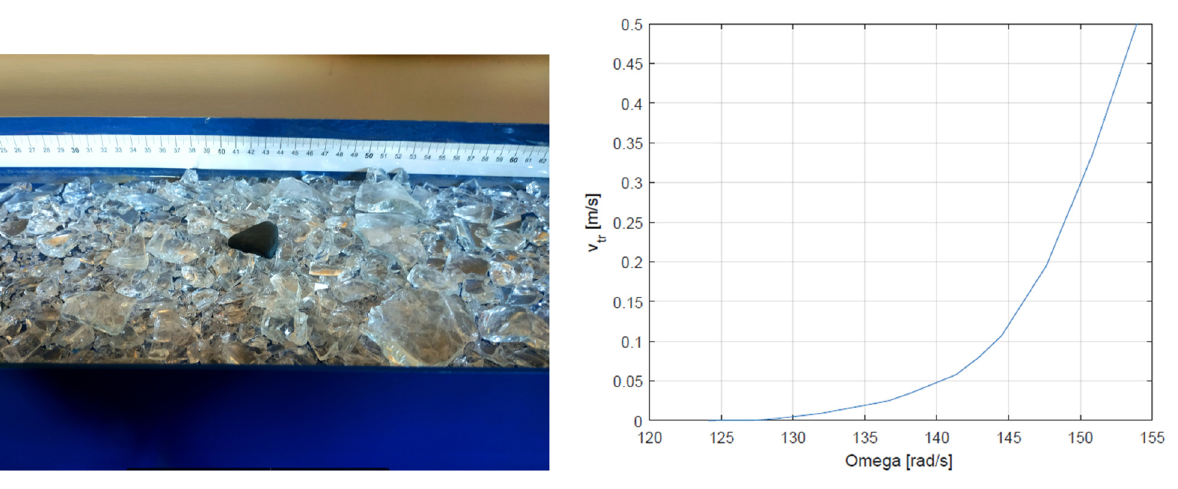
Figure 11: Trough carrying glass chippings.